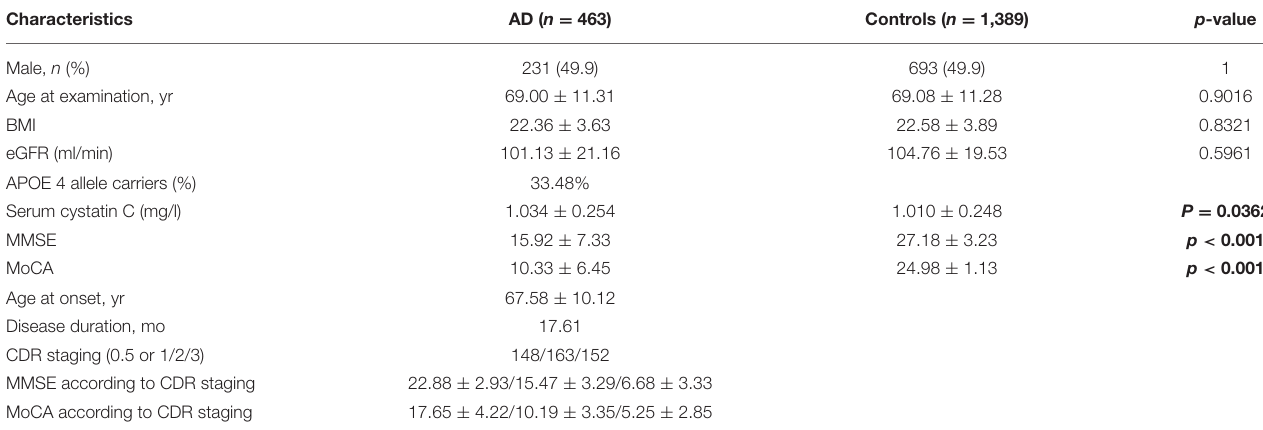
TABLE 1 | Demographic and clinical characteristics of patients with AD and healthy controls. Characteristics